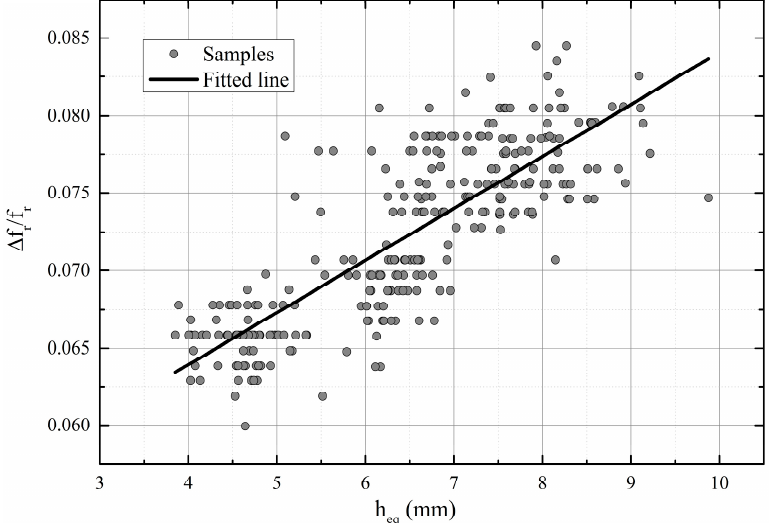
Figure 5. The relative resonant frequency shift vs. thickness of the equivalent water